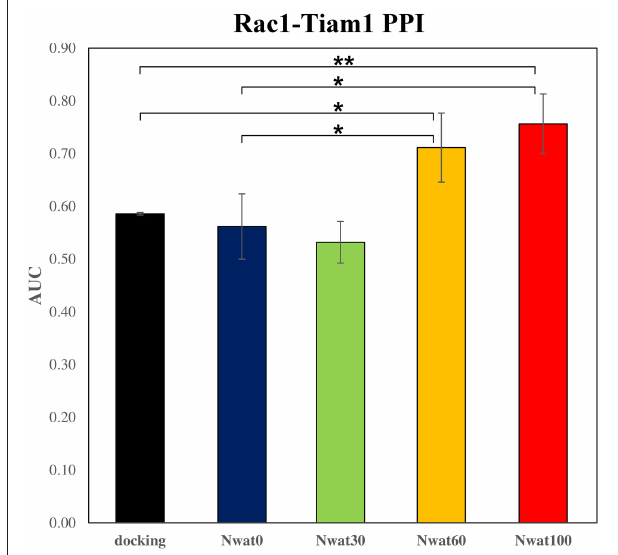
FIGURE 7 | Average ROC AUC values for Rac1-Tiam1 virtual screenings. Statistical significance was calculated by t -test and is graphically reported only when a significant variation was observed (* P < 0.05; ** P <